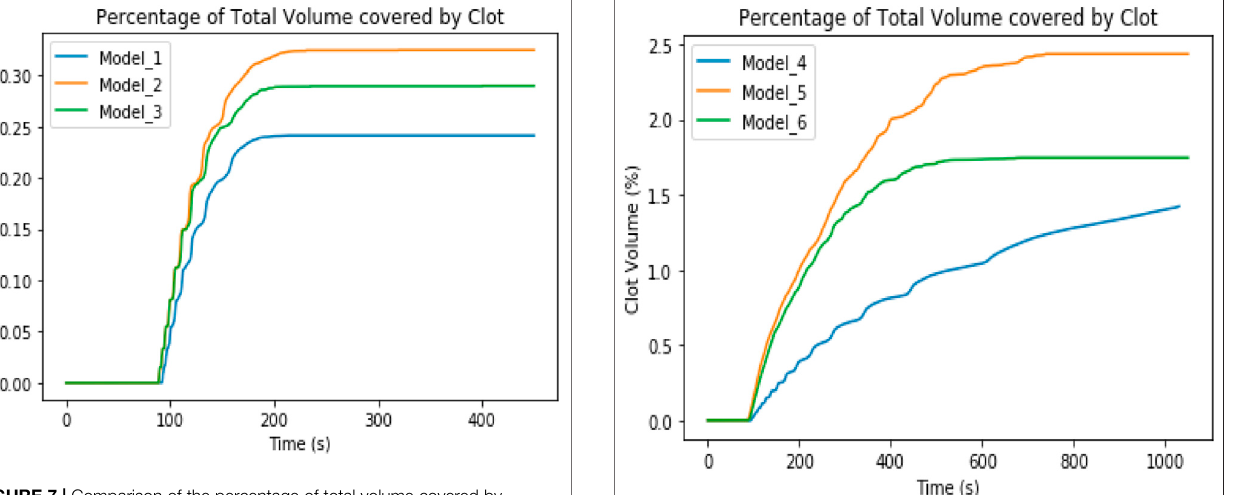
FIGURE 7 | Comparison of the percentage of total volume covered by the clots in Models_1, 2, and 3 (three-dimensional model).